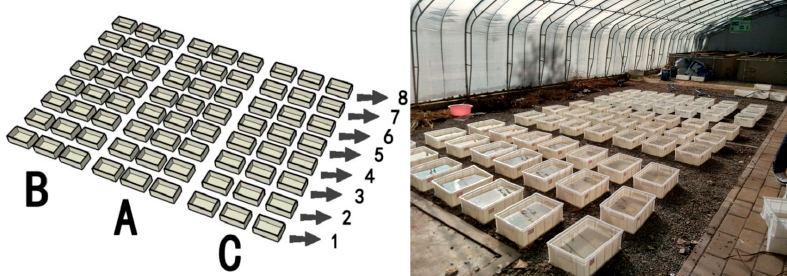
Figure 1. Experimental set-up and photo of experimental design. A, B, C represented three types of water substrates: polluted water, purified water and natural tap water. Numbers 1–7 represent the 7 species placements, and number 8 represents the control treatment (no litter submergence).